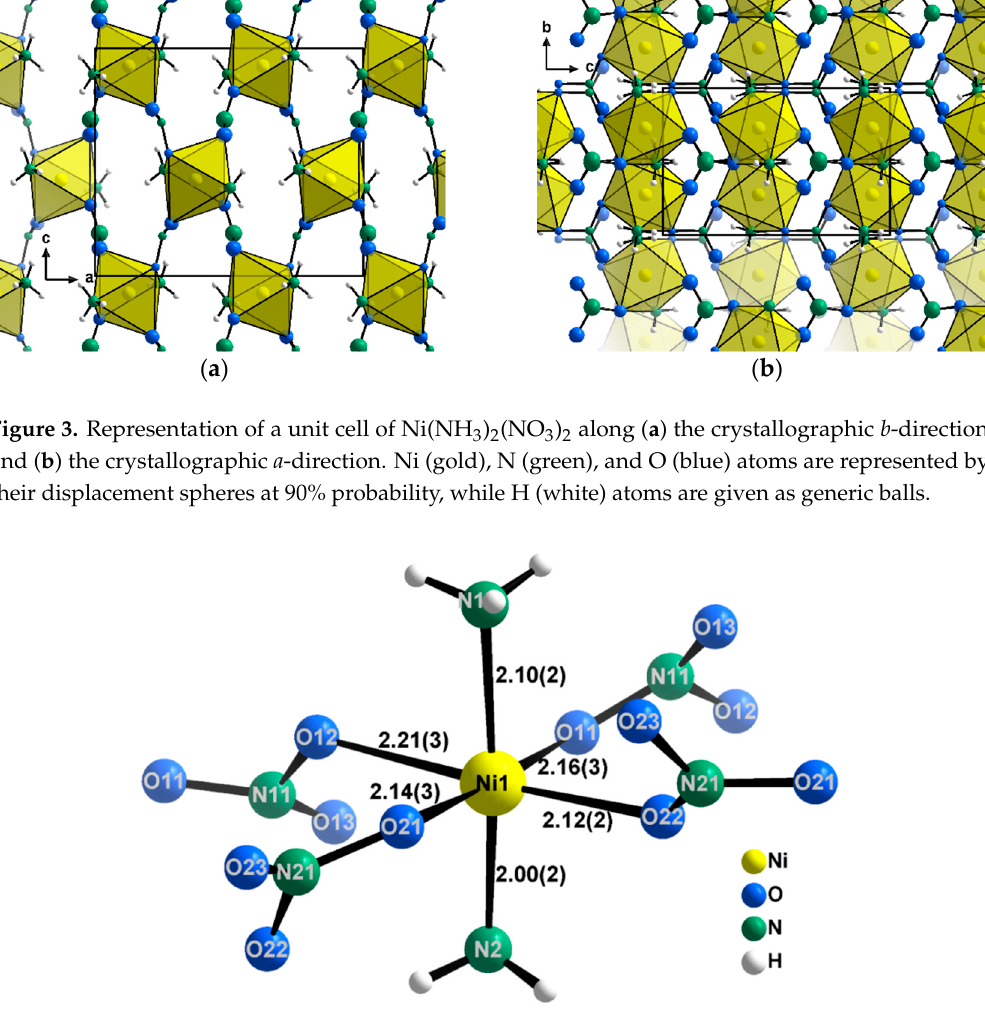
Table 3. Interatomic distances in Ni(NH 3 ) 2 (NO 3 ) 2 .